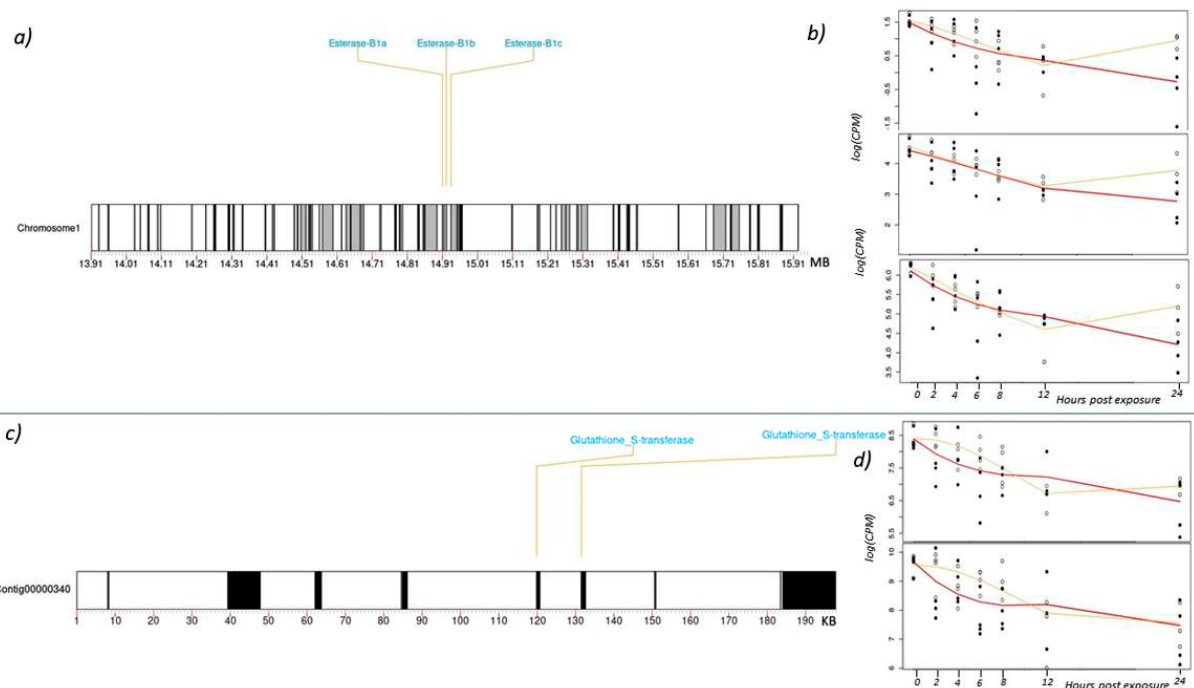
Figure 3. ( a ) Ideogram of the boll weevil gene region surrounding the three tandem esterase B1 genes on Chromosome 1. ( b ) Expression of each esterase B1 over 24 h (log transformed counts per million). The yellow line indicates the transcriptomic response to the low concentration treatment and the red line indicates the high concentration treatment. Closed circles represent gene expression values for individual weevils exposed to the high concentration of malathion, and open circles are weevils exposed to the low concentration. ( c ) Schematic of two tandem glutathione S-transferases (GST) and the surrounding 198 KB region on contig: ctg00000340. ( d ) Expression of each GST over 24 h (log transformed counts per million). The yellow line indicates the transcriptomic response to the low concentration treatment and the red line indicates the high concentration treatment. Closed circles represent gene expression values for individual weevils exposed to the high concentration of malathion, and open circles are weevils exposed to the low